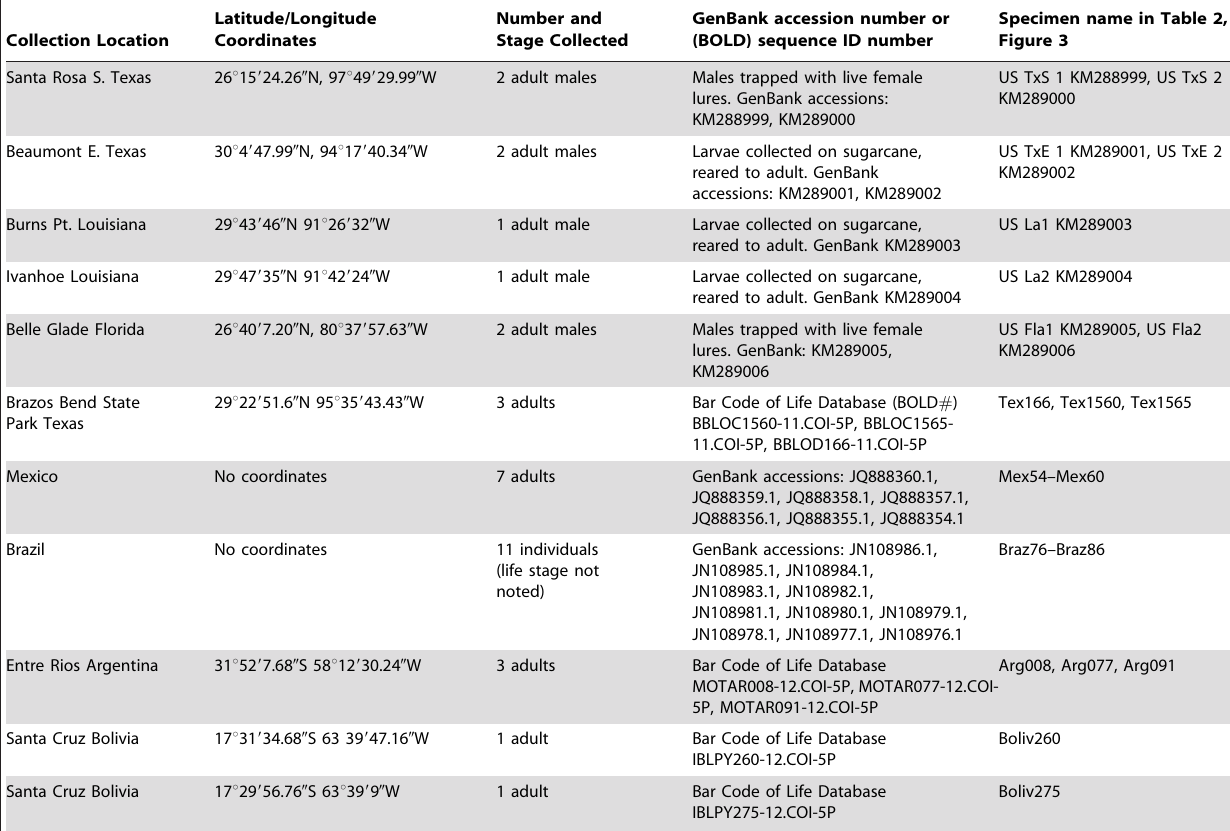
Table 1. Collection localities for D. saccharalis .